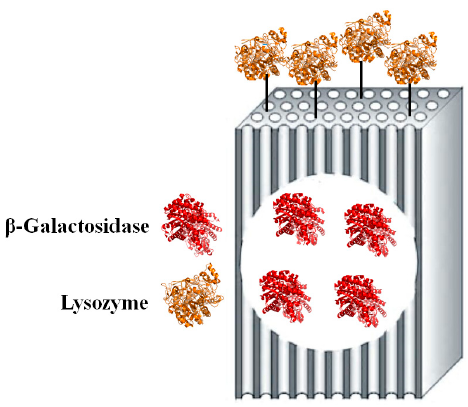
Figure 1. The strategy for co-immobilisation of the two enzymes relative to the silica substrate.